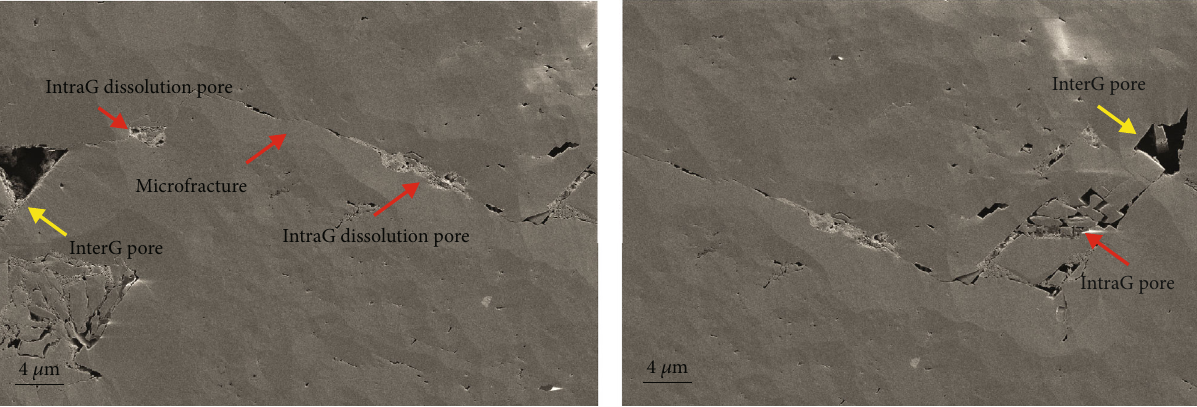
Figure 6: FE-SEM photomicrographs (SE mode) for sample SHY 1-002-3: intergranular pores and intragranular (dissolution) pores are developed and connected by fractures at micro- and